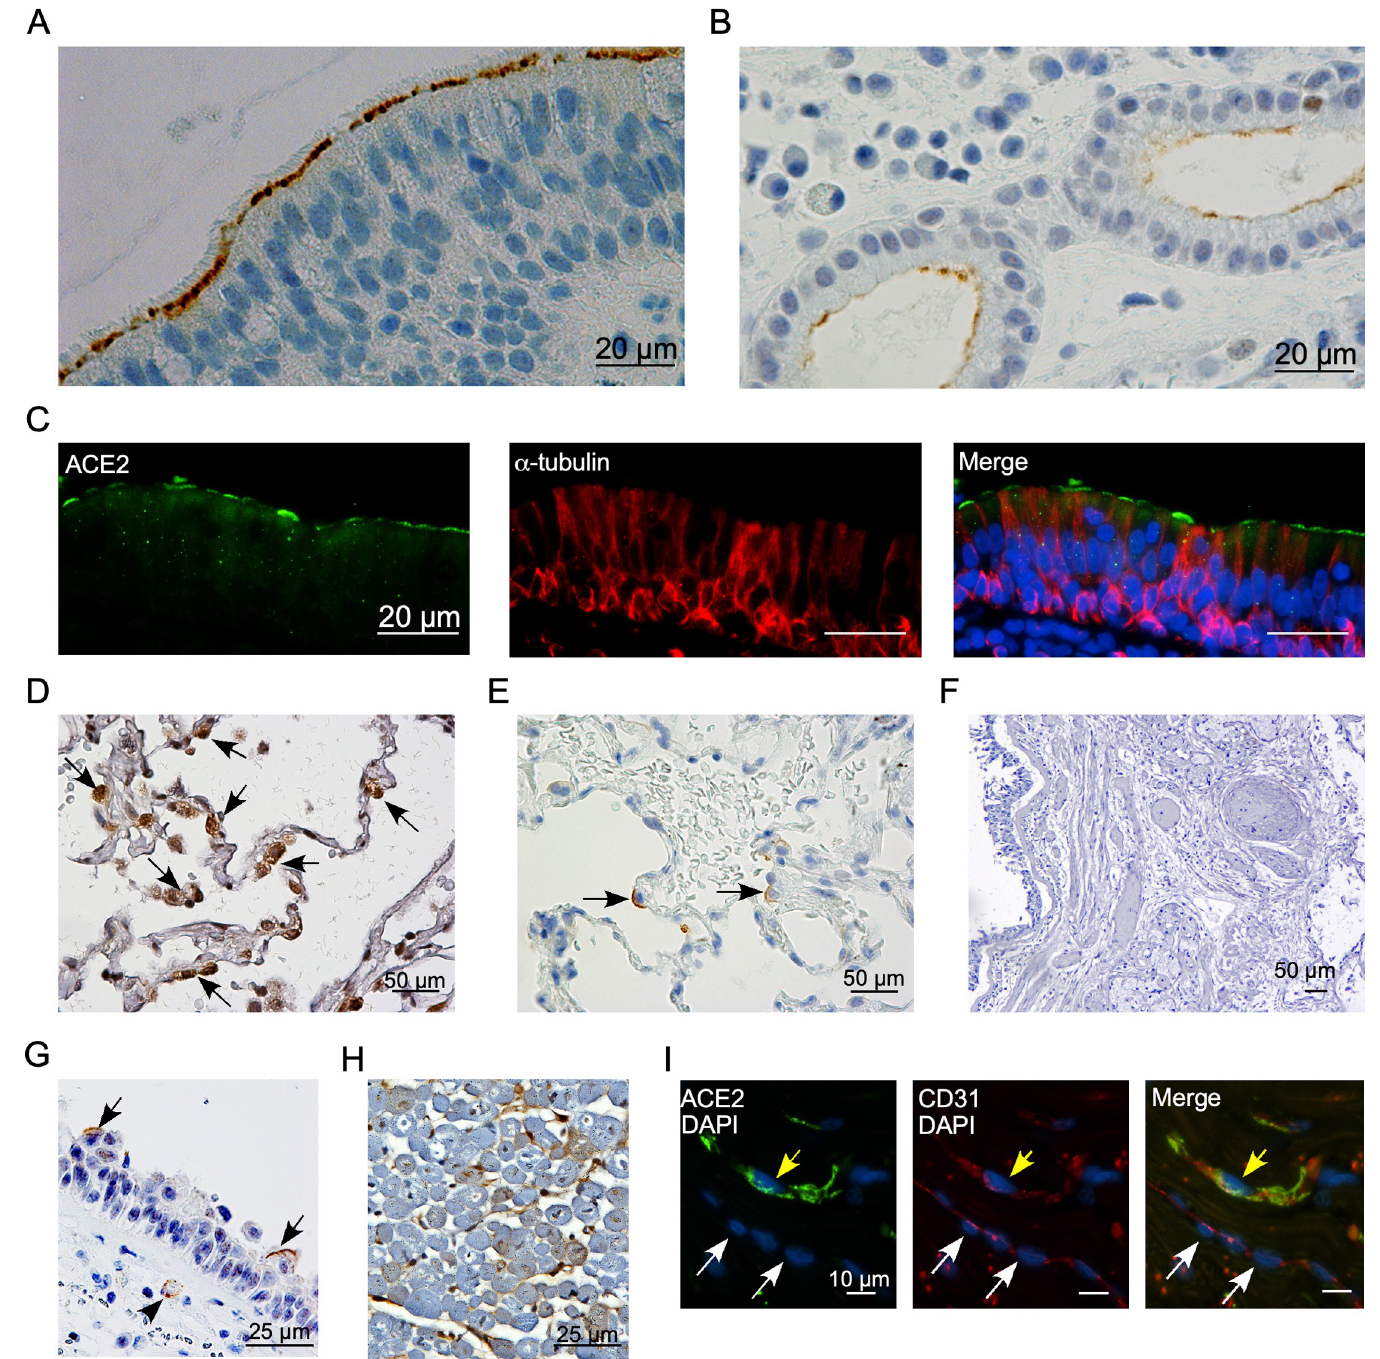
Fig 3. Robust ACE2 detection in ciliated epithelial cells in the upper but not lower airways in human specimens. Representative images of ACE2 IHC on control human paranasal sinus section showing ACE2 immunoreactivity in ciliated epithelial cells (A) and submucosal glandular epithelial cells (B). Double IF analysis confirmed co-localization of ACE2 in the ciliated epithelial cells with α -tubulin (C). Representative IHC for pro-SPC (D) and ACE2 (E) on control human lung sections; black arrows indicate pro-SPC positive AT2s in panel “D” and ACE2-positive AT2s in panel “E”. Representative IHC for ACE2 on an autopsy lung section (F) and trachea (G) from patients who died of COVID-19. Black arrows indicate ACE2-positive ciliated epithelial cells and black arrowhead indicates a capillary blood vessel with ACE2 immunoreactivity in the lamina propria. Representative IHC for ACE2 (H) and double IF for ACE2 and CD31 (I) on control heart sections; yellow arrow indicates a capillary blood vessel with ACE2 and CD31 co-localization and white arrows indicate a larger blood vessel without ACE2 signal.